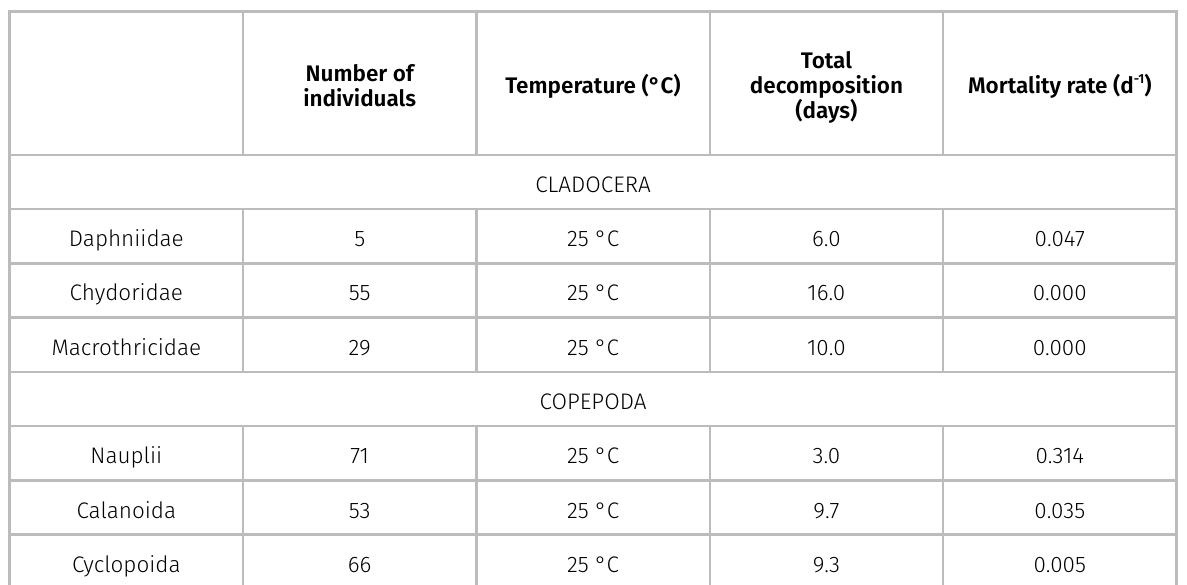
Table II. Results of laboratory experiments to determine the non-predatory mortality rate of planktonic microcrustaceans in three reservoirs in neotropical semiarid ecosystems (Pernambuco,